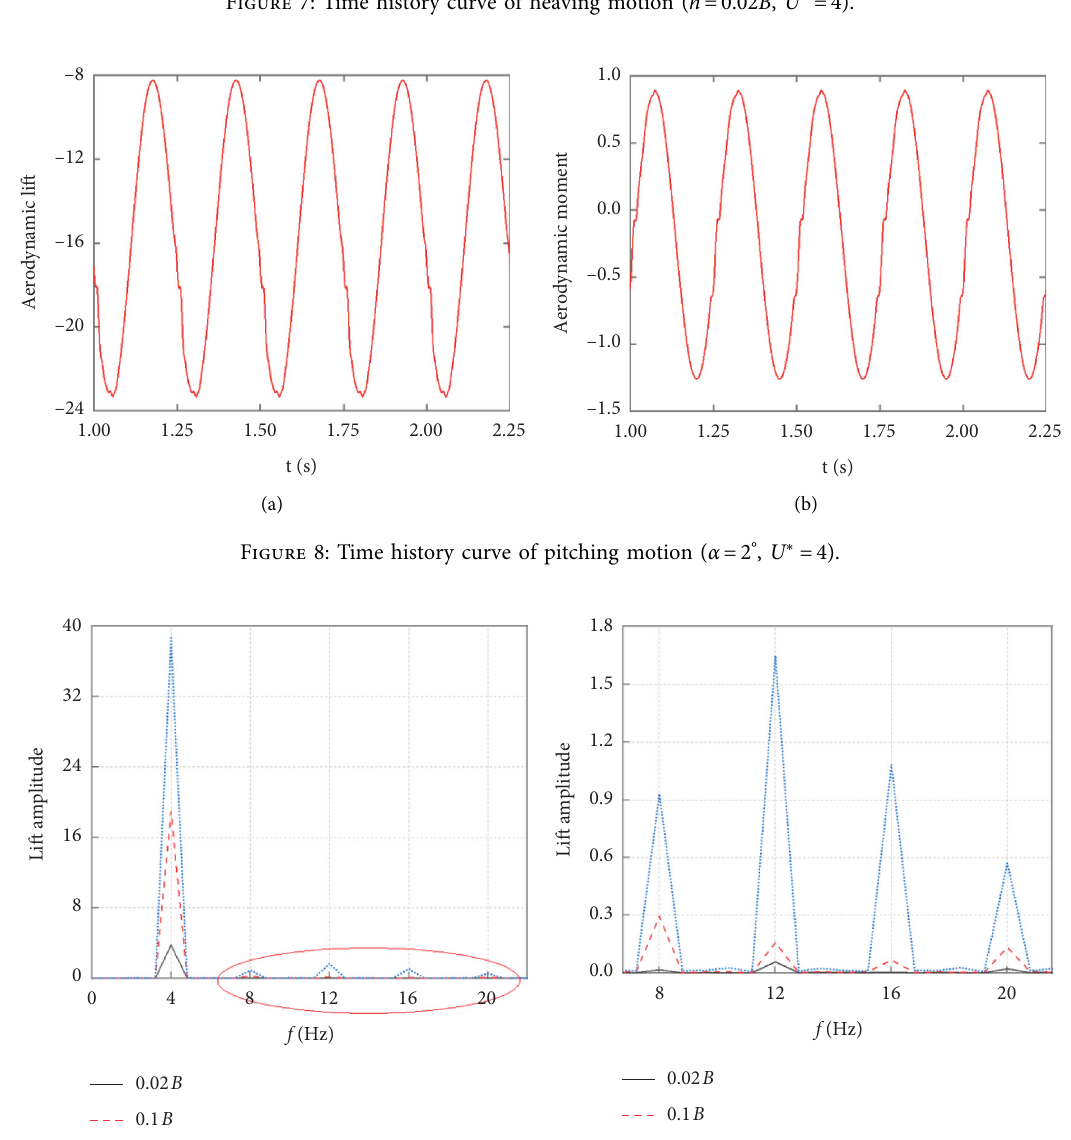
Figure 7: Time history curve of heaving motion ( h � 0.02 B , U ∗ � 4).